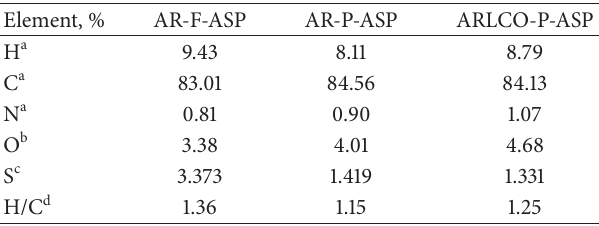
Table 1: Element analysis of asphaltene fractions in feed and products.